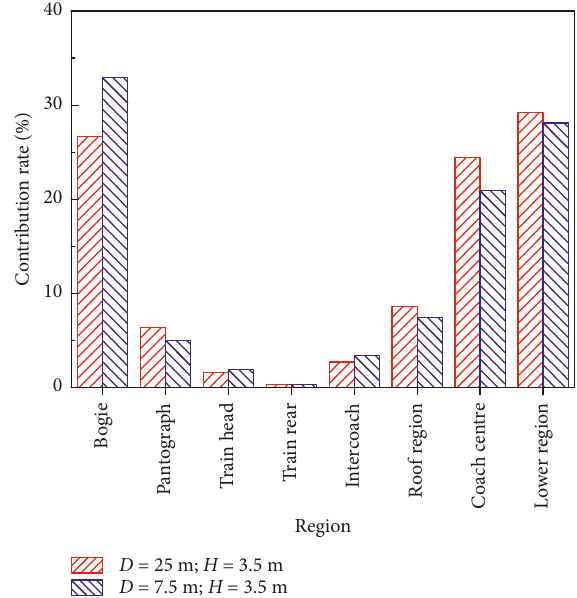
Figure 16: Contribution rates of the exterior sound sources to the pass-by noise (350